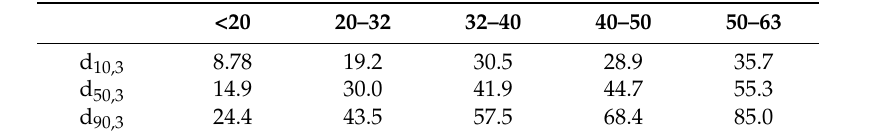
Table A1. Characteristic weight percentiles of sieved powder fractions, 95 wt% Al, 5wt. % Cu, all in micrometers.